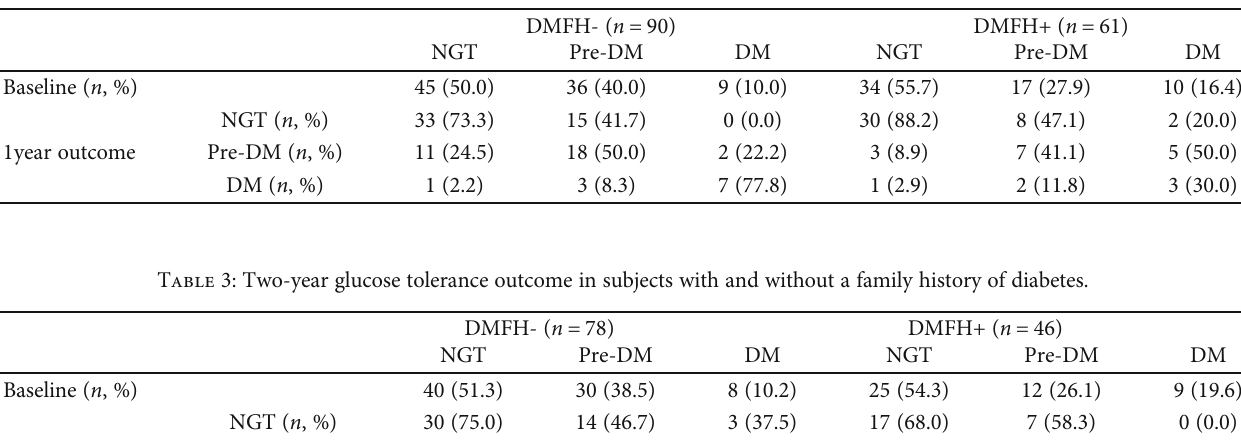
Table 2: One-year glucose tolerance outcome in subjects with and without a family history of diabetes.